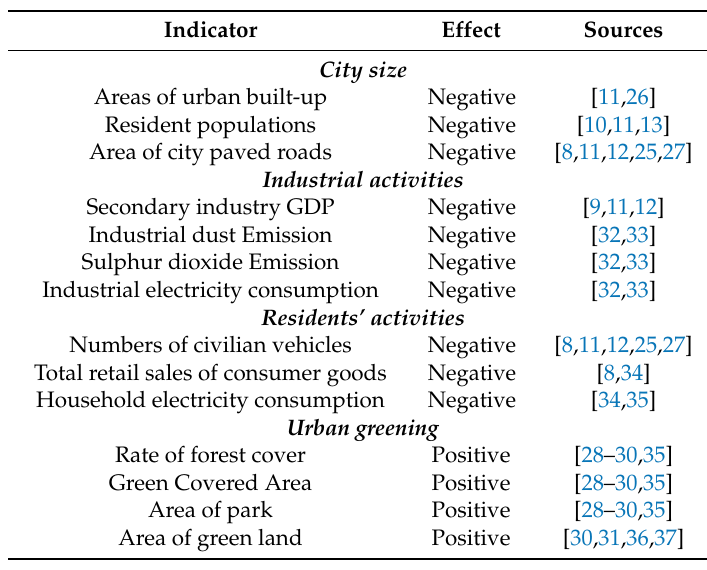
Table 1. Selected socioeconomic indicators and the source of